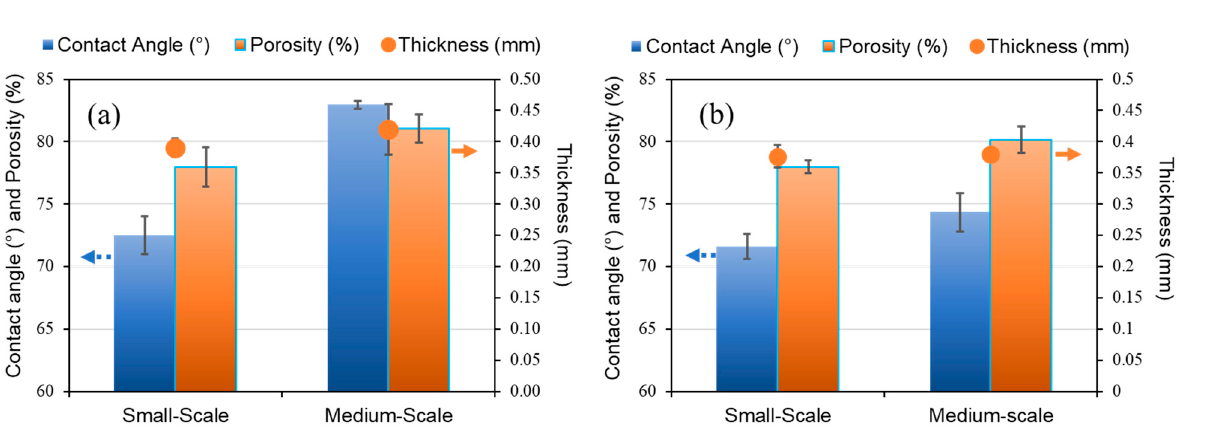
Figure 5. Porosity, contact angle, and thickness of produced hollow fiber membranes in each batch. Small scale: 1.5 kg batch; medium scale: 20 kg batch. ( a ) Fibers made with PVDF 1 dope; ( b ) fibers made with PVDF 2 dope.